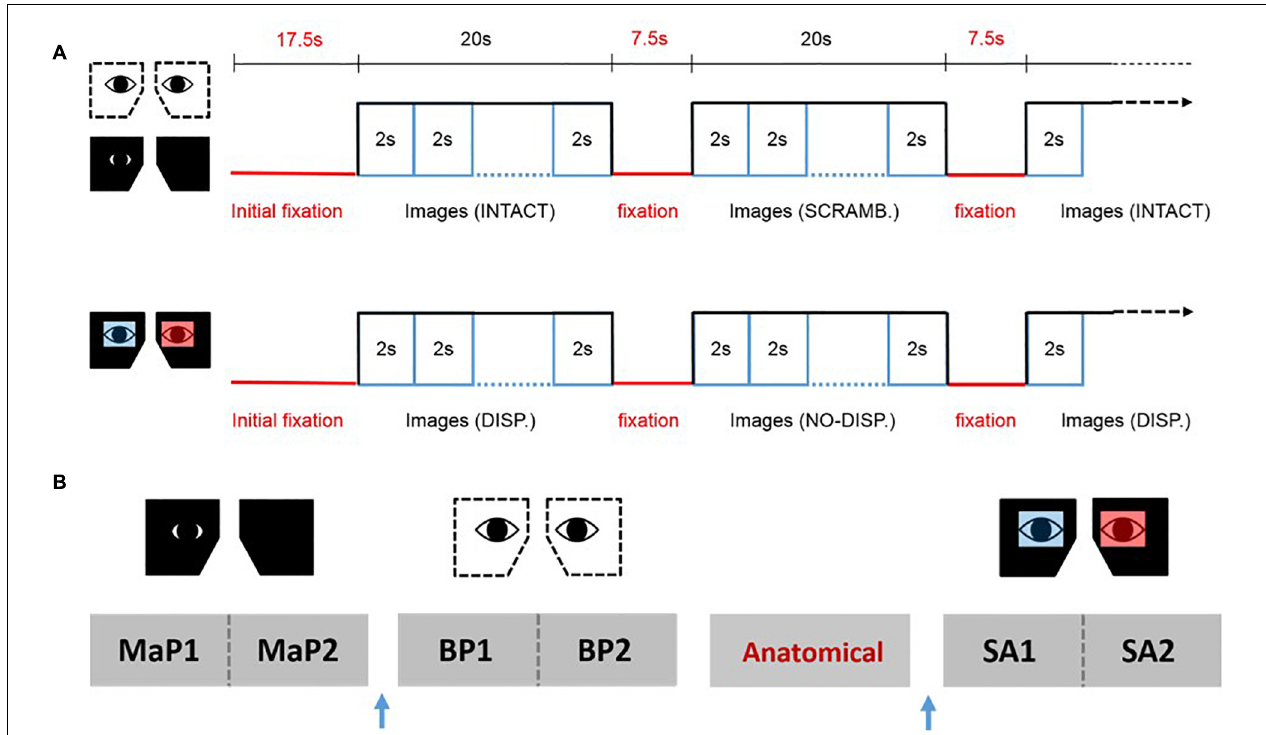
FIGURE 2 | fMRI design. (A) The upper panel shows the stimulus sequence for the binocular pictorial (BP) and monocular-aperture pictorial (MaP) conditions, while the lower panel shows the sequence for the stereoscopic anaglyph (SA) condition. (B) An example sequence of the functional runs and anatomical scans for one participant. Two runs for each viewing condition were done consecutively with a brief break in between. The order of the viewing conditions and the anatomical scan was partially counterbalanced across participants. The blue arrow represents partial bed retractions to change